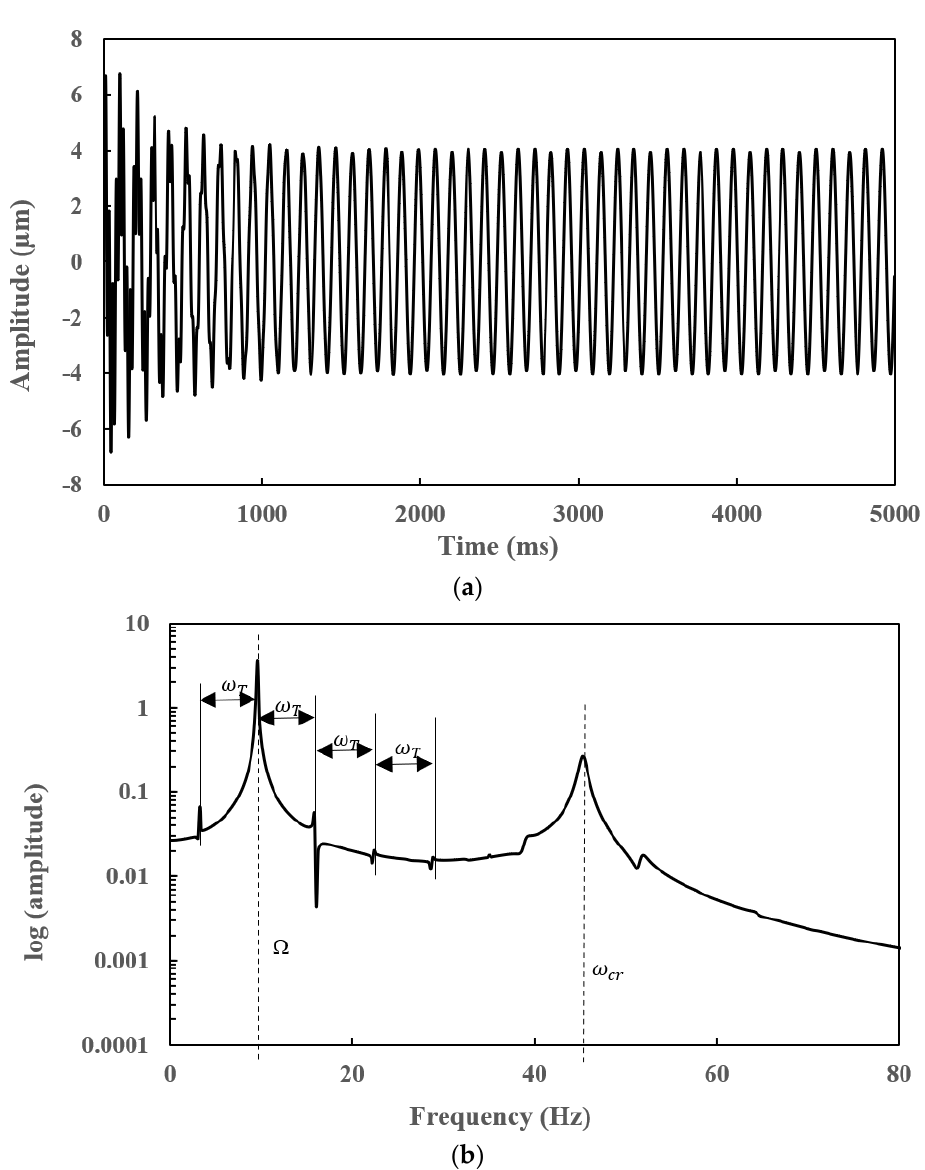
Figure 9. Steady − state ( a ) time response and corresponding ( b ) FFT of a slant − cracked EG rotor − bearing system with a rotor speed of 60 rad/s, and torsional frequency ( 𝜔 (cid:3021) ) = 40 rad/s for 𝛼(cid:3364) = 0.3 .